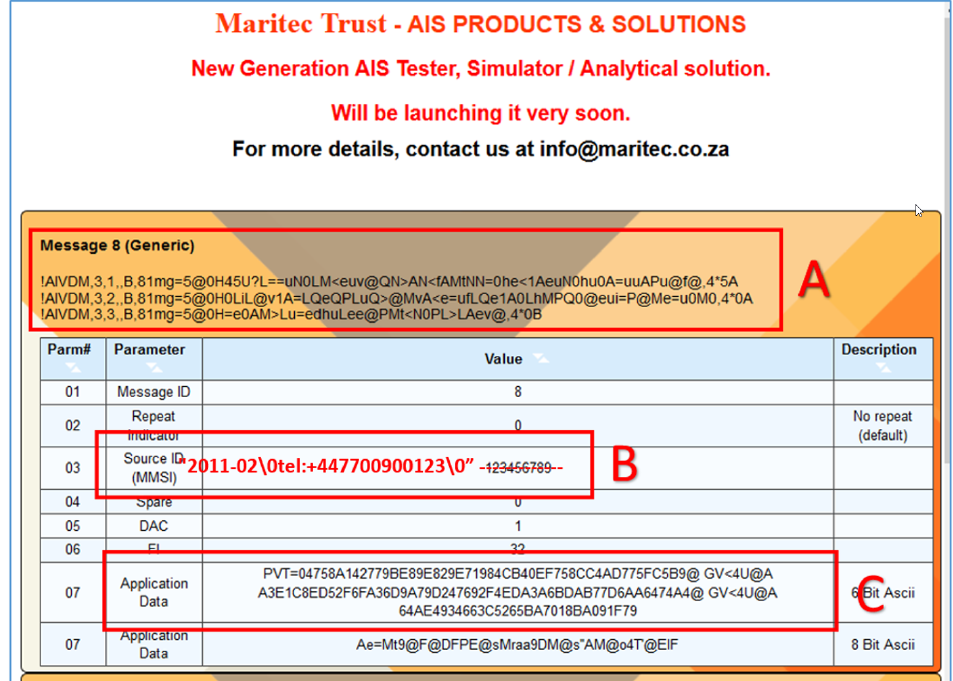
Figure 8. ID8 AIS message ( A ); PVT of the Transmitter ( C ); source MMSI ( B